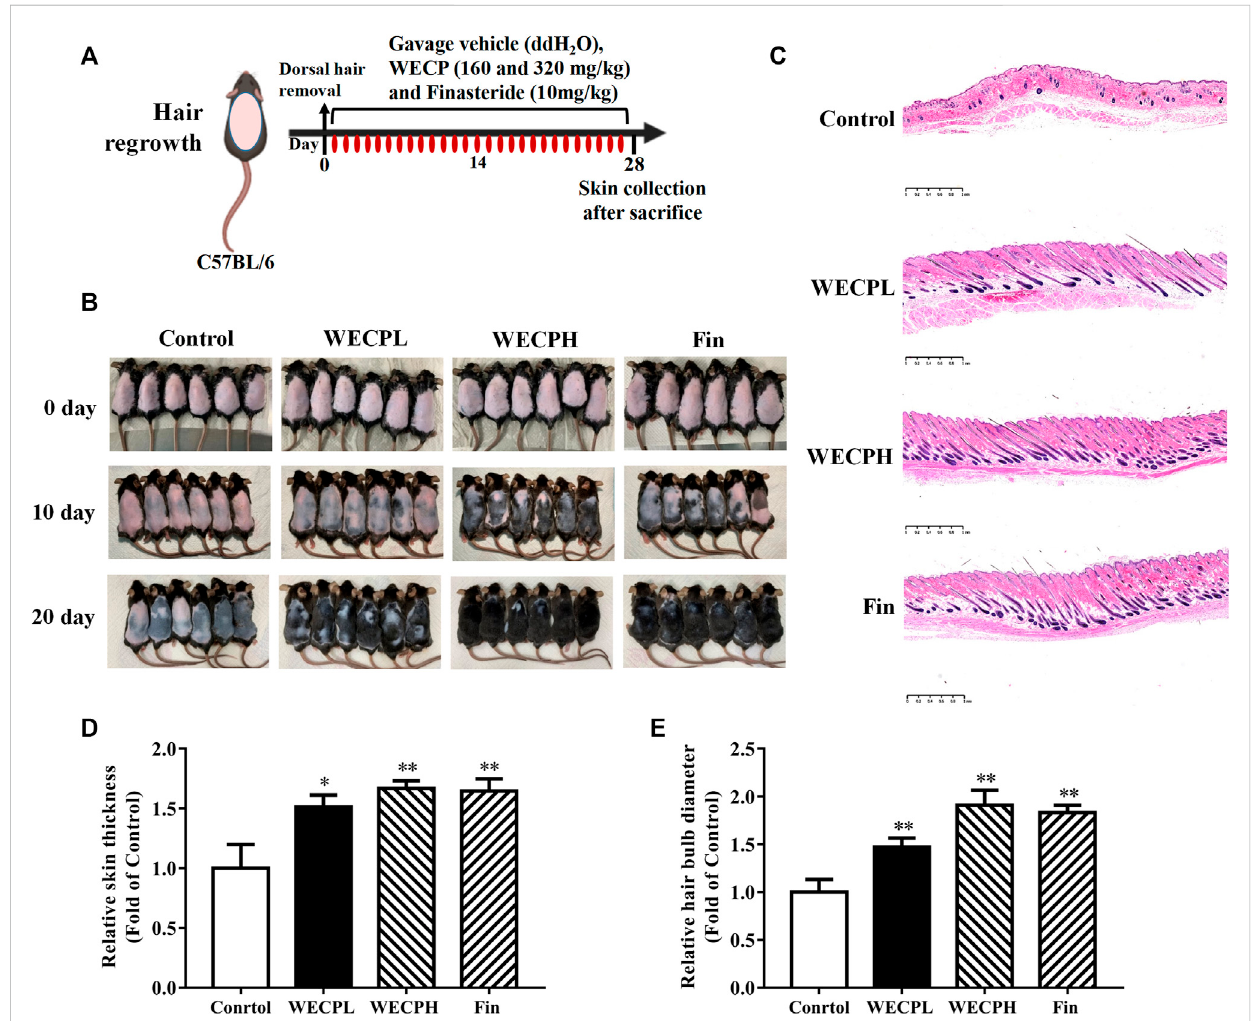
WECP promotes hair regrowth in vivo . (A) Back skin of 7-week-old C57BL/6 mice was shaved. WECP (160 mg/kg and 320 mg/kg) and fi nasteride (10 mg/kg) were administered daily by gavage for 20 days. (B) Photographs of dorsal skin on days 10 and 20 after depilation. (C) Depilated mouse skin tissue sections were prepared and histologically examined using H & E staining. Images were captured using a digital pathology scanner. (D, E) Skin thickness and hair bulb diameter were measured. N = 6. Scale bars = 1 mm. WECPL, WECPH, and Fin represent low-dose WECP, high-dose WECP, and fi nasteride treatment, respectively. * p < 0.05, ** p < 0.01 vs. control